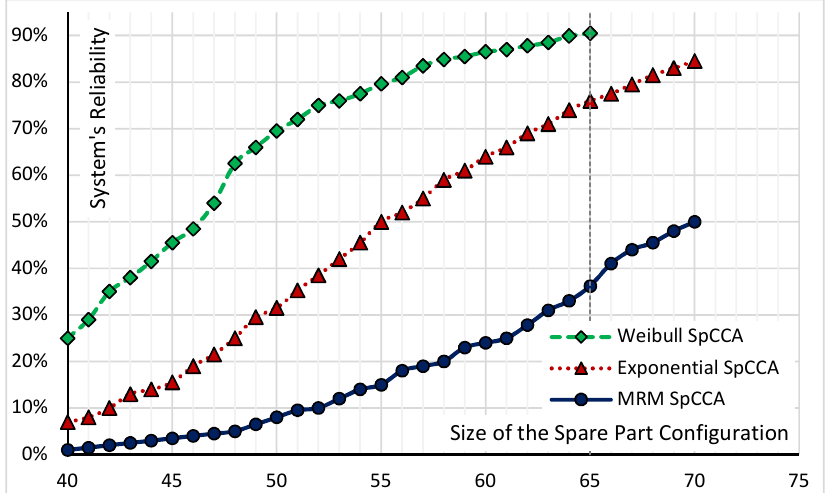
Fig. 3 . An example of the Pareto Optimal Frontier generated by the three constructive algorithms The Pareto optimal frontier generated by the SpCCA is the only one that stops before the budget has been fully utilized. As soon as the target reliability of 90% is reached, with the purchase of 65 spare parts, the algorithm stops. Conversely, due to the underestimation of the true value of the system’s reliability, neither the Exponential (in red) nor the MRM (in blue) approach reaches the target and so, new spare parts are continuously added, until the budget runs